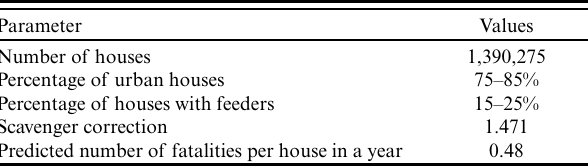
Table 2 . Input parameters for the Monte-Carlo simulation for calculating bird–window collision mortality at houses in